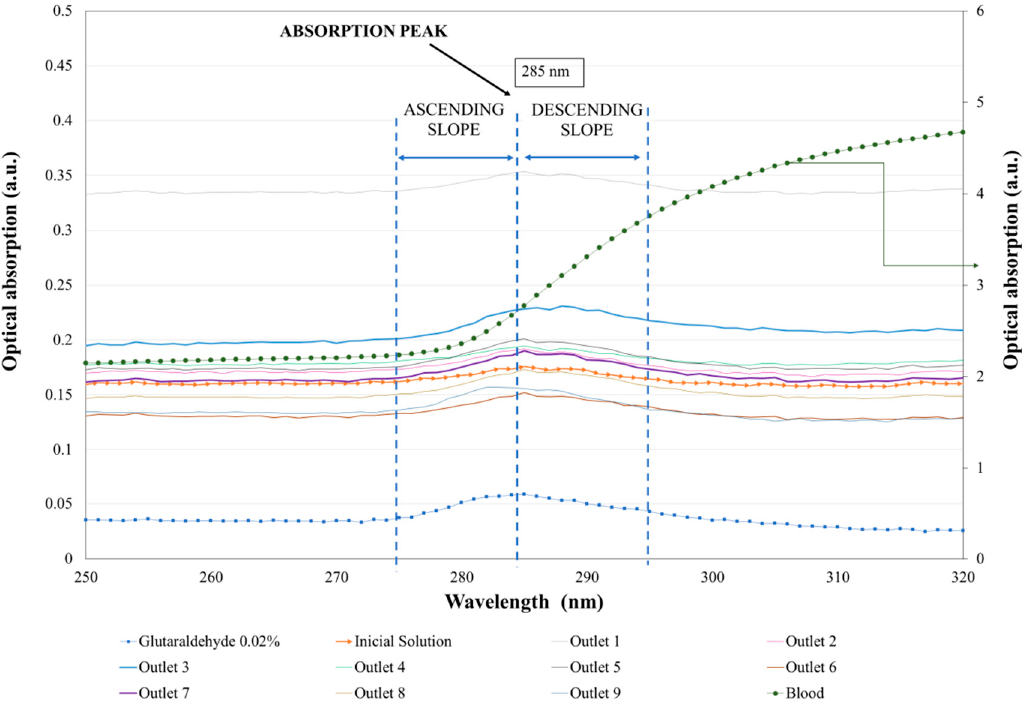
Figure 4. Average curves (n = 3) of the optical absorption spectra (a.u.) in the UV region of blood, glutaraldehyde, the initial working solution, and the samples collected in all the microchannel outlets (O1–O9). Note that the blood sample has an absolute optical absorption higher than all the other curves and, as a consequence, a secondary axis of optical absorption was added to the graphic (right axis).